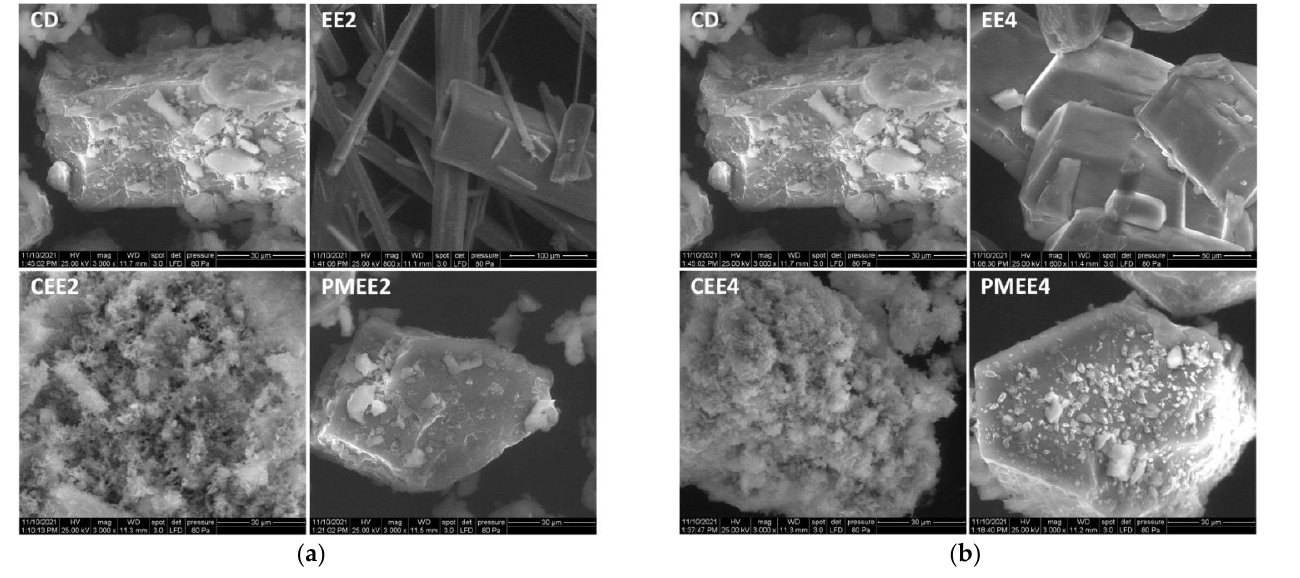
Figure 2. SEM images of β -cyclodextrin, ethyl ester, inclusion complex, physical mixture: ( a ) ethyl 2-(2-((2-chlorophenyl)carbamoyl)phenoxy)acetate series; ( b ) ethyl 2-(2-((4-chlorophenyl) car- bamoyl)phenoxy)acetate series.